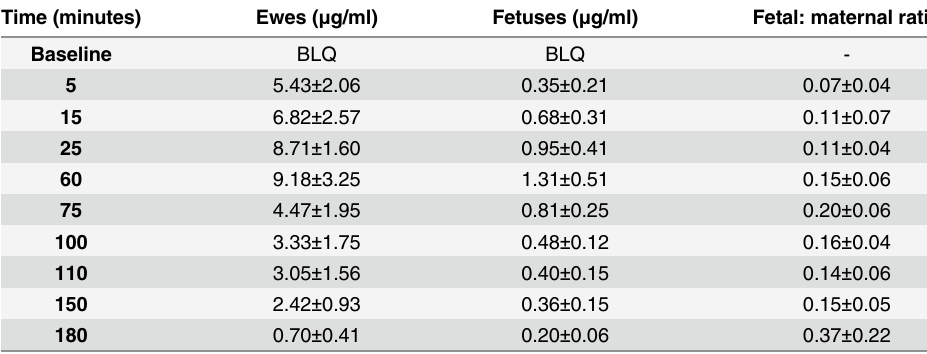
Table 1. Plasma propofol concentration ( μ g/ml) in the ewes and the fetuses.